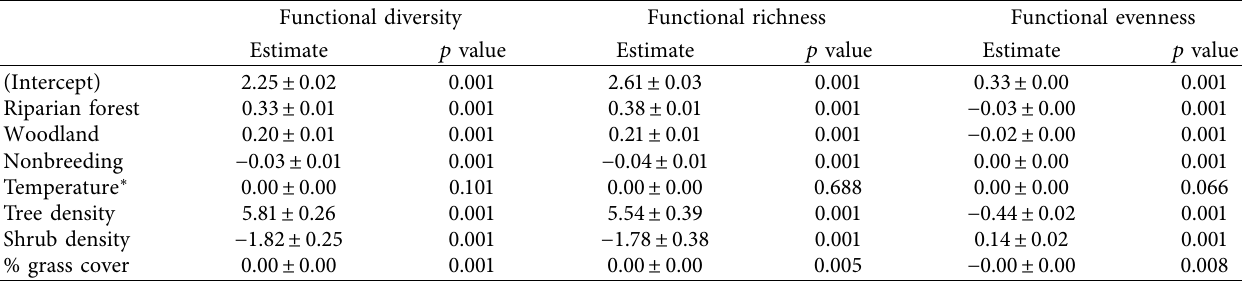
Table 1: Summary table of model estimates of avian functional diversity measures versus temperature and vegetation